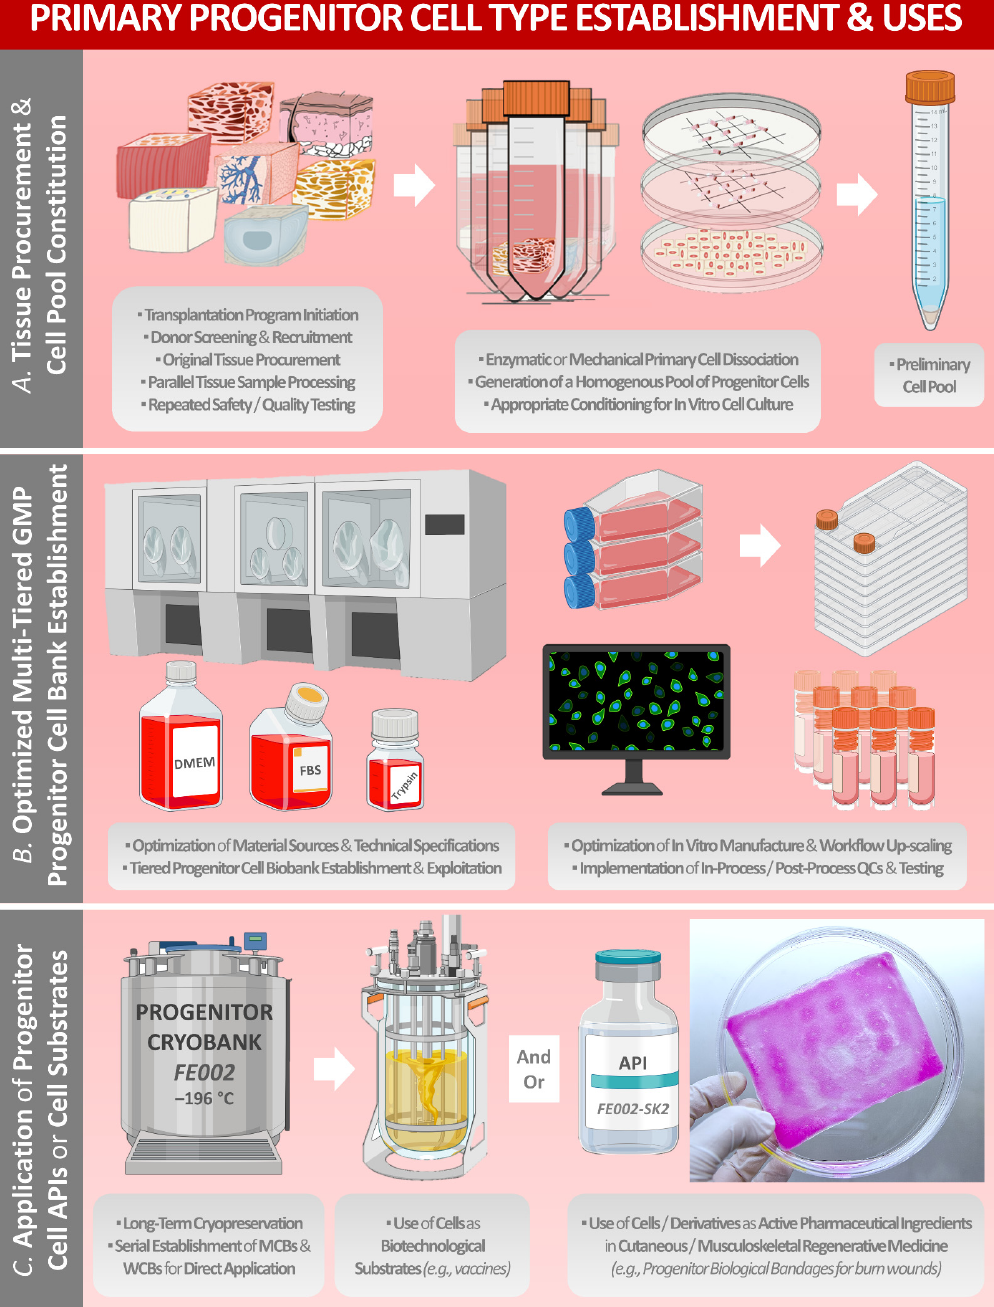
Figure 1. Schematic technical overview of the established workflows for optimized primary progenitor-cell-type establishment and of related industrial applications. ( A ) Using ad hoc and well-defined methodological processes for the original tissue procurement, the appropriate in vitro primary-cell-isolation procedures are applied to obtain a homogenous preliminary pool of primary progenitor cells. ( B ) Following stringent manufacture-optimization steps, the multi-tiered GMP cell banking is performed to constitute the primary progenitor-cell banks. ( C ) The established and qualified cell stocks of primary progenitor cells may then be used as biotechnological substrates or as cytotherapeutic APIs in specialized regenerative medicine. API, active pharmaceutical ingredient; DMEM, Dulbecco’s modified Eagle medium; FBS, fetal bovine serum; GMP, good manufacturing practices; MCB, master cell bank; QC, quality control; WCB, working cell